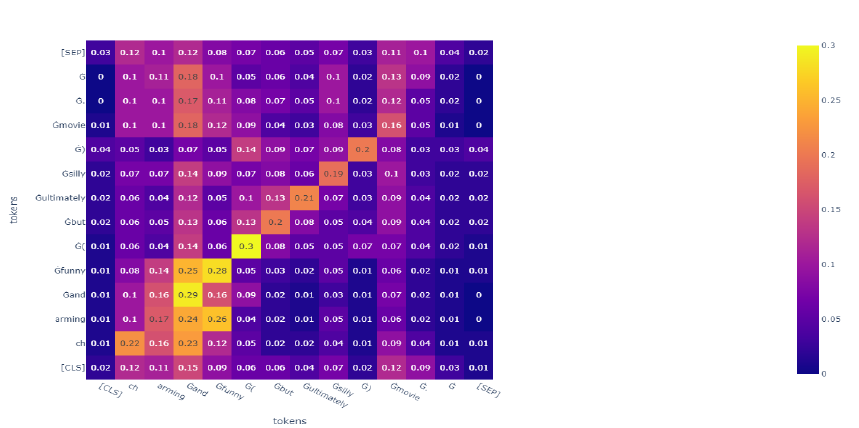
Figure 6. The attention heat map of phrase, “charming and funny ( but ultimately silly ) movie.”, in the RoBERTa model.